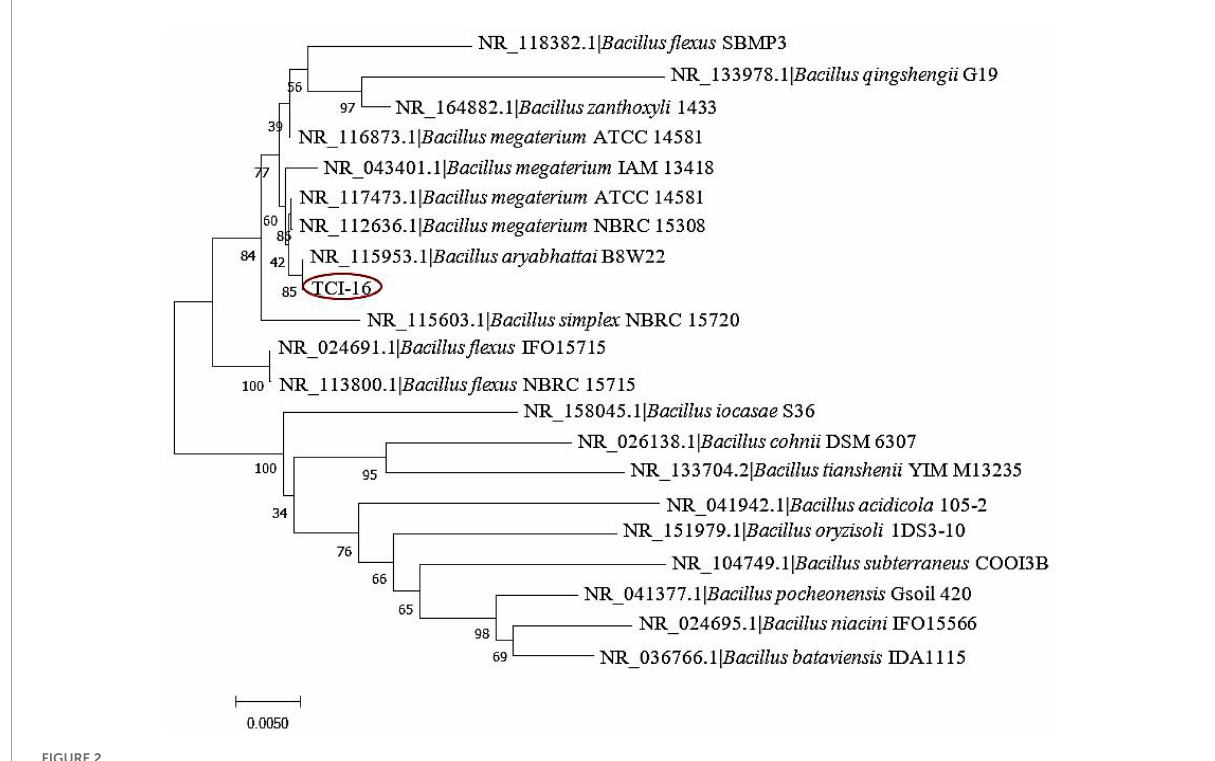
FIGURE2 Phylogenetic tree of the strain TCI-16 based on 16S rDNA sequence.